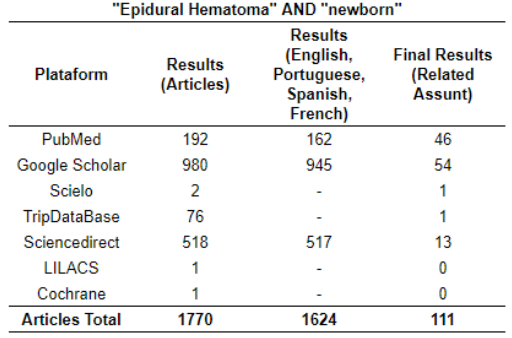
Table 1. Results with the term “Epidural Hematoma” AND “Newborn”